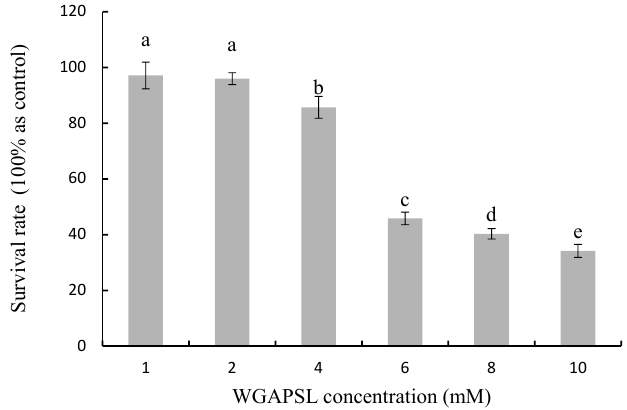
Figure 1. Cytotoxicity of Trp-Gly-Ala-Pro-Ser-Leu (WGAPSL) in Caco-2 cells as evaluated by the CCK-8 assay. Data are the mean values ± standard variation of three replications. Di ff erent letters (a, b, c, and d) indicate a significant di ff erence at p <